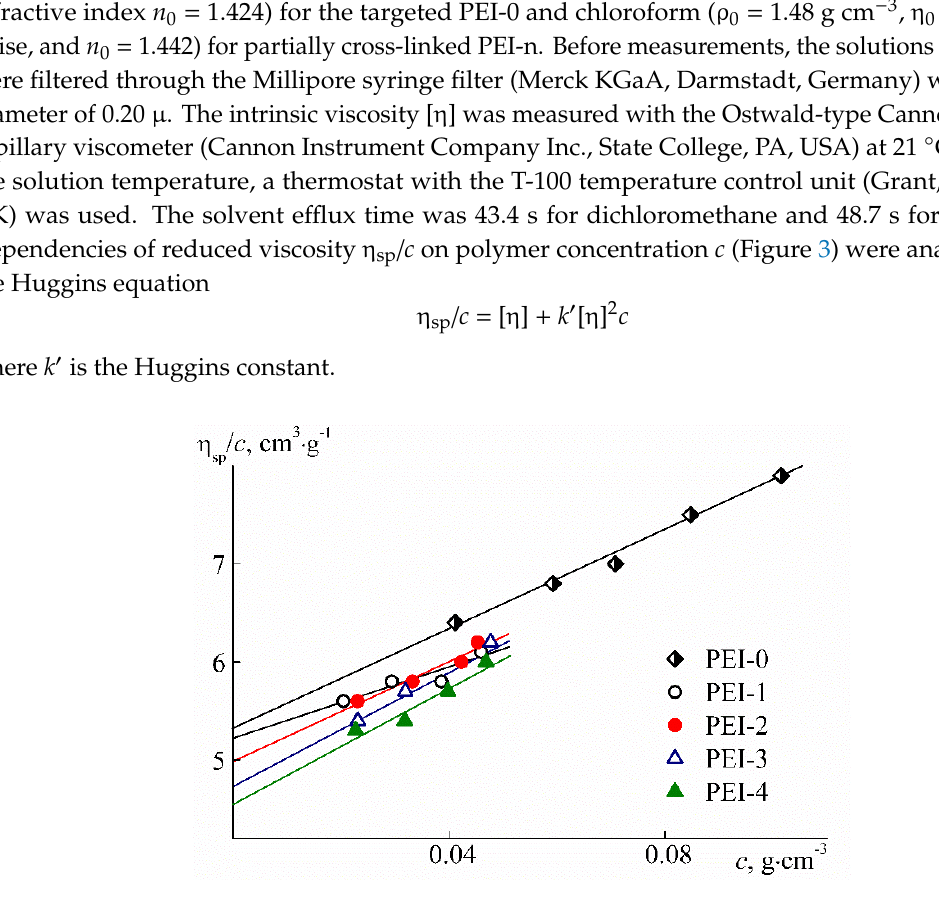
Figure 3. Dependencies of reduced viscosity sp / c on concentration c for solutions of PEI-0 in dichloromethane and PEI-n in chloroform.